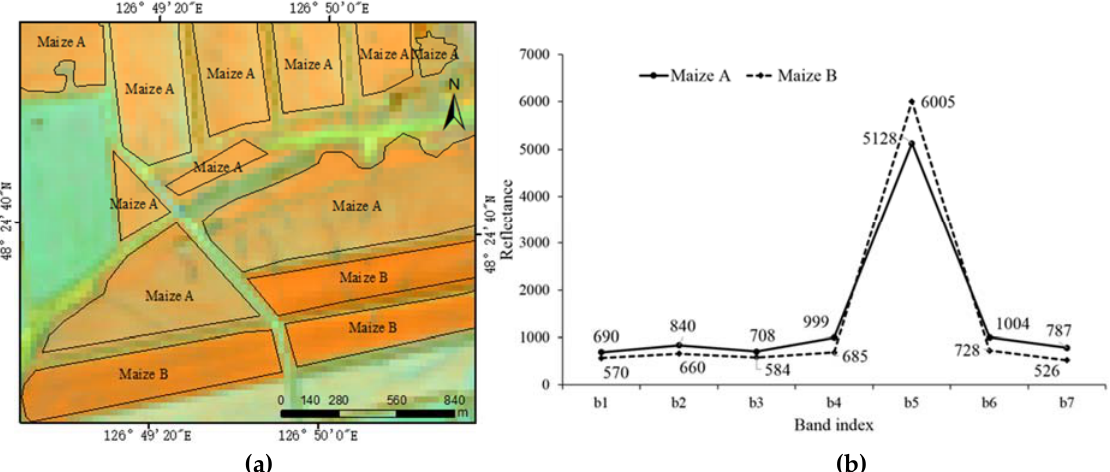
Figure 13. The same objects with different spectra. ( a ) Different colors of tow sub-classes of maize in the Landsat image of DOY 260 (NIR, SWIR1 and red as R, G, B); and ( b ) the spectra of maize A and maize B.